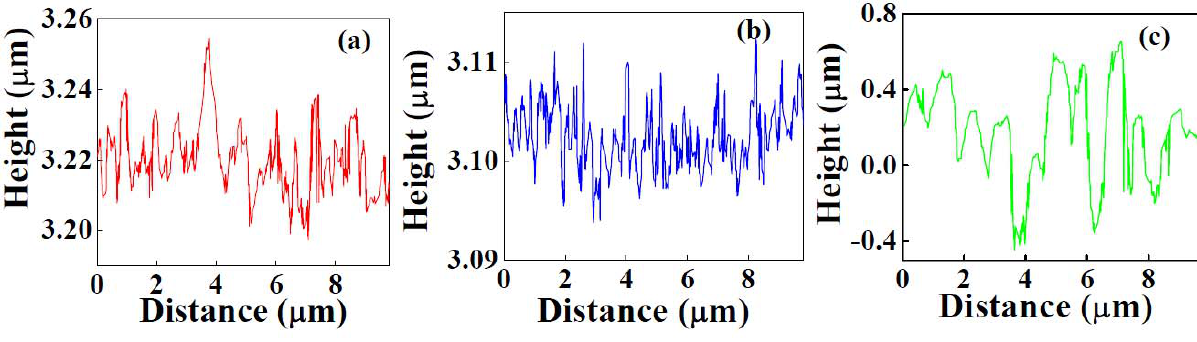
Figure 5. Surface roughness profiles of: ( a ) sputter deposited Y oxidized Y-Y